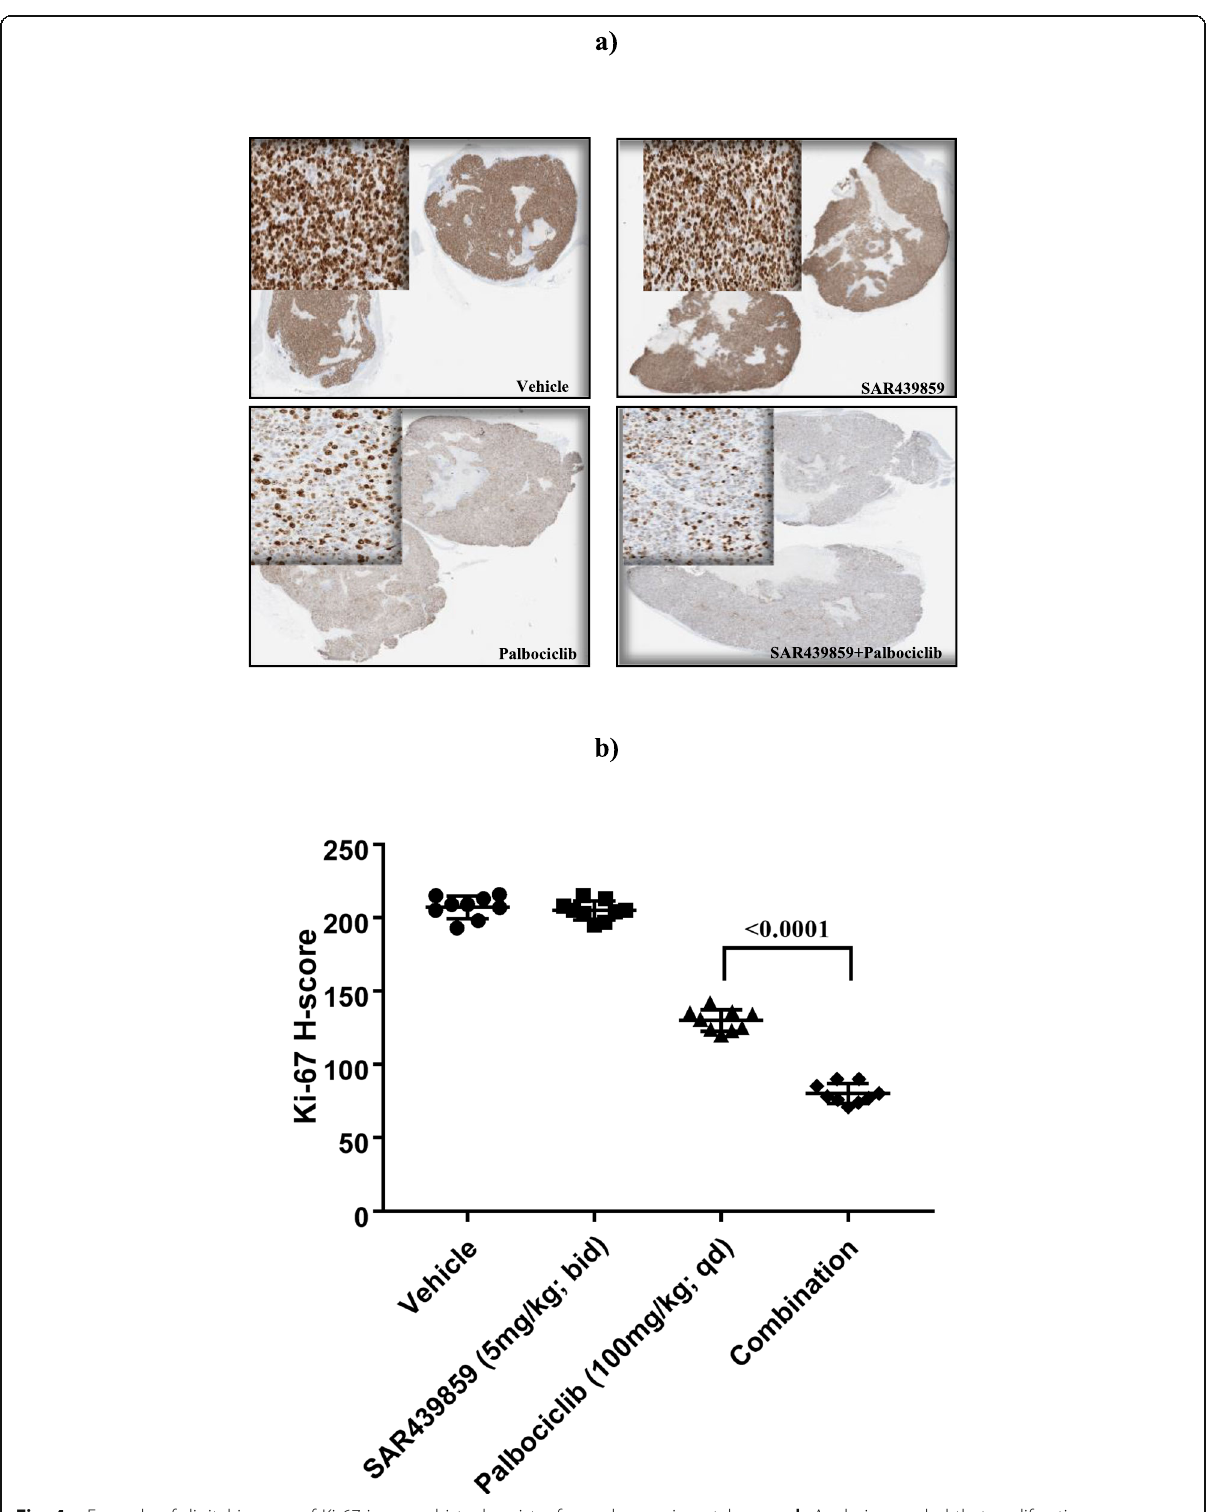
Fig. 4 a Example of digital images of Ki-67 immunohistochemistry for each experimental group. b Analysis revealed that proliferation was severely impaired after palbociclib administration alone or in combination with